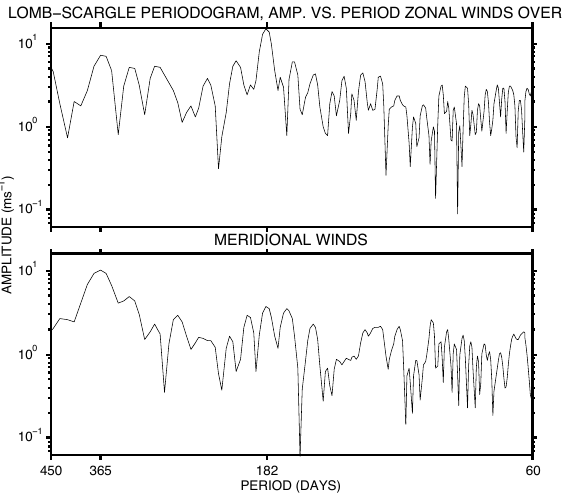
Fig. 2. A Lomb–Scargle periodogram of the zonal and meridional Fig. 2. A Lomb-Scargle periodogram of the zonal and meridional winds at a height of about winds at a height of about 90km over Ascension Island for October 90km over Ascension Island for October 2001 to December 2011. 2001 to December peaks and calculating the QBO period that they would be modulated by. From Fig. 2 and using the following equation: 1 / ω 1 - 1 / ω 2 = 1 / ω QBO . Where, ω 1 is the first lobe peak, 162 days and ω 2 is the second lobe peak, 207 days and ω QBO is the period of the QBO. It was found that frequency of the modulating wave was calculated to be about 25 months, approximately the QBO frequency. Therefore the QBO does seem to modulate the amplitude of the SAO as the broadening of the peak as suggested by the side-lobes either side of the SAO in the figure. In contrast, in the meridional winds